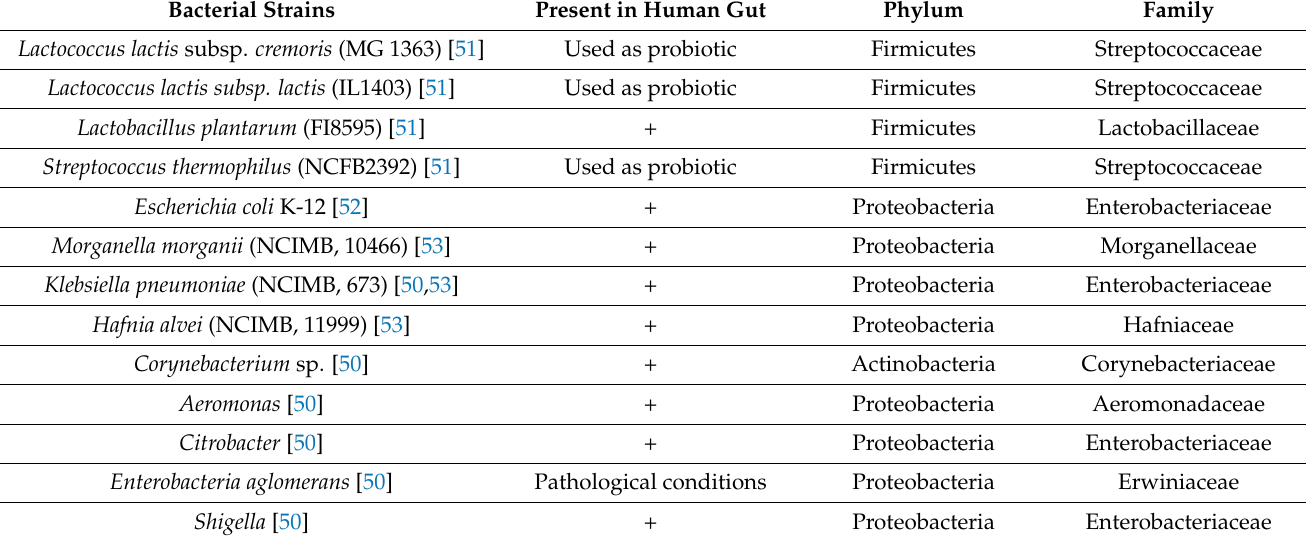
Table 2. Bacterial species capable of 5-HT